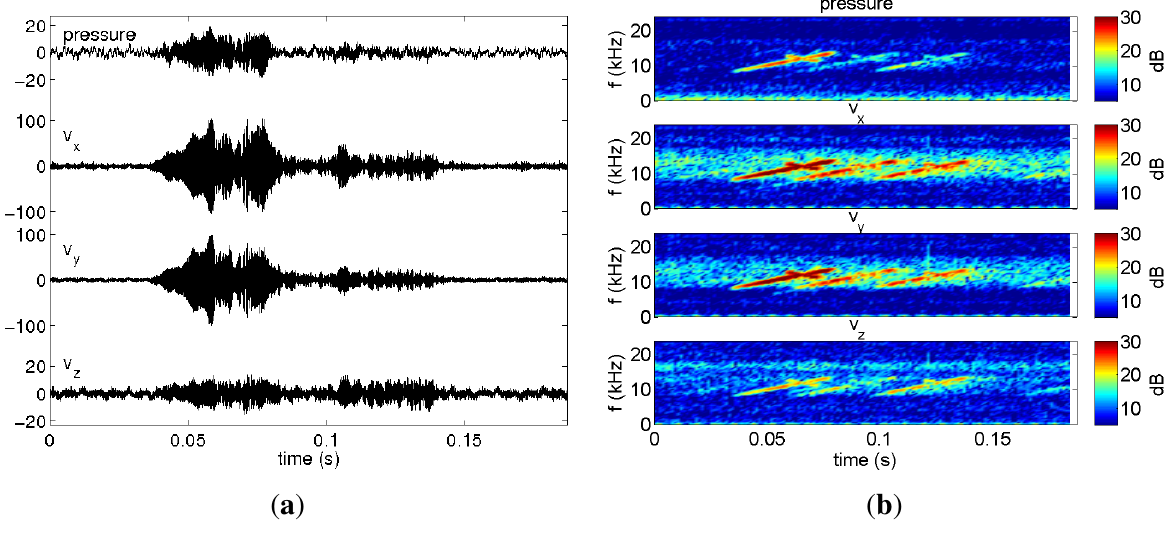
Waveforms received from a 350 m distant source for the various vector sensor components ( a ) and respective spectrograms ( b